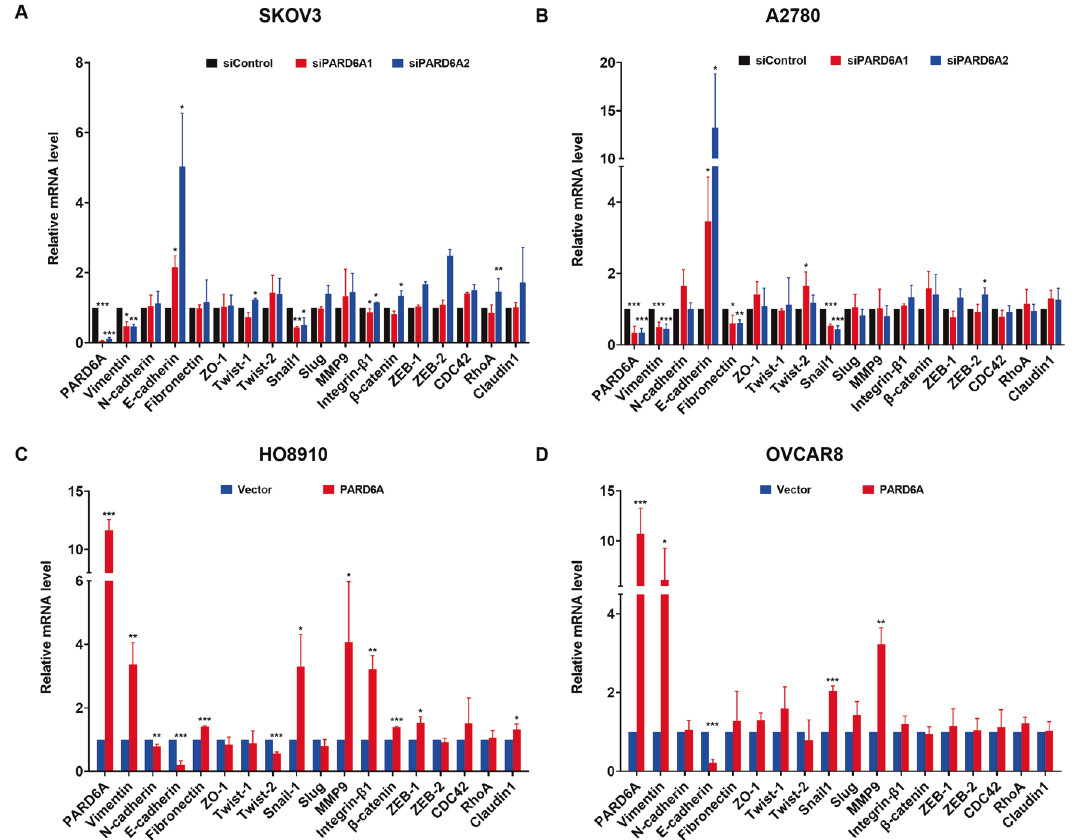
Fig. 4 mRNA expression of EMT-associated genes potentially affected by PARD6A expression. mRNA expression of EMT-associated genes in SKOV3 ( A ) and A2780 cells ( B ) with PARD6A silenced. mRNA expression of EMT-associated genes in HO8910 ( C ) and OVCAR8 cells ( D ) with PARD6A overexpressed. Data shown are the mean values (±SD) from three independent experiments and relative values of mRNA expression of the genes when expression of PARD6A manipulated versus the expression of them when transfected with siControls. Statistically signi fi cant differences with P < 0.05 were considered signi fi cant (* P < 0.05; ** P < 0.01; *** P <